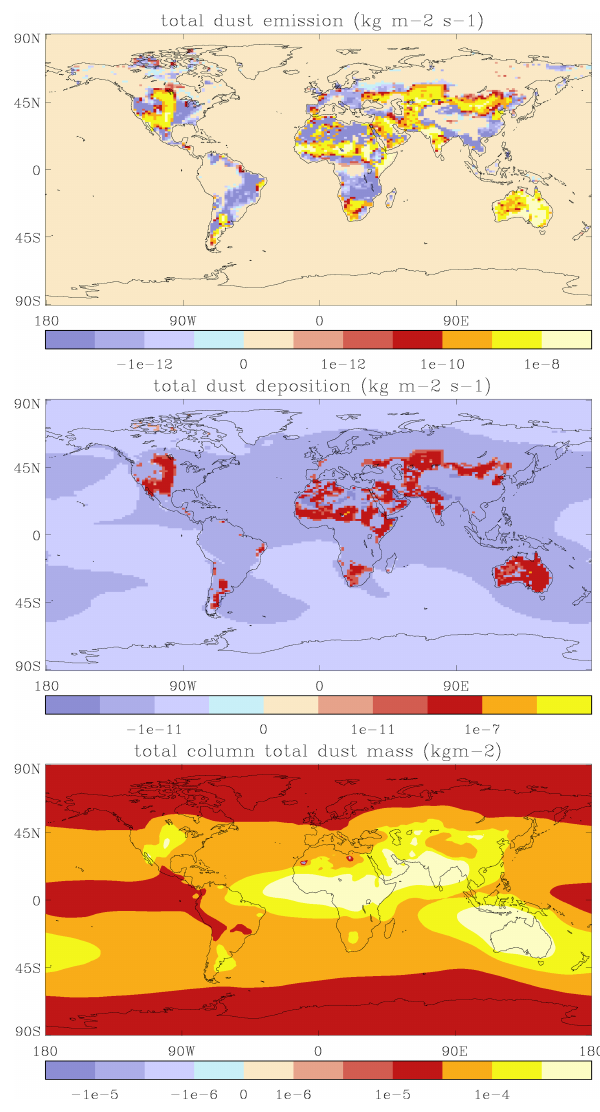
Fig. 6. Change in annual climatology of dust emission, depo- sition and total column dust mass between HadGEM2-AE and HadGEM2-A simulations (with and without land cover from HadGEM2-ES). Note the non-linear